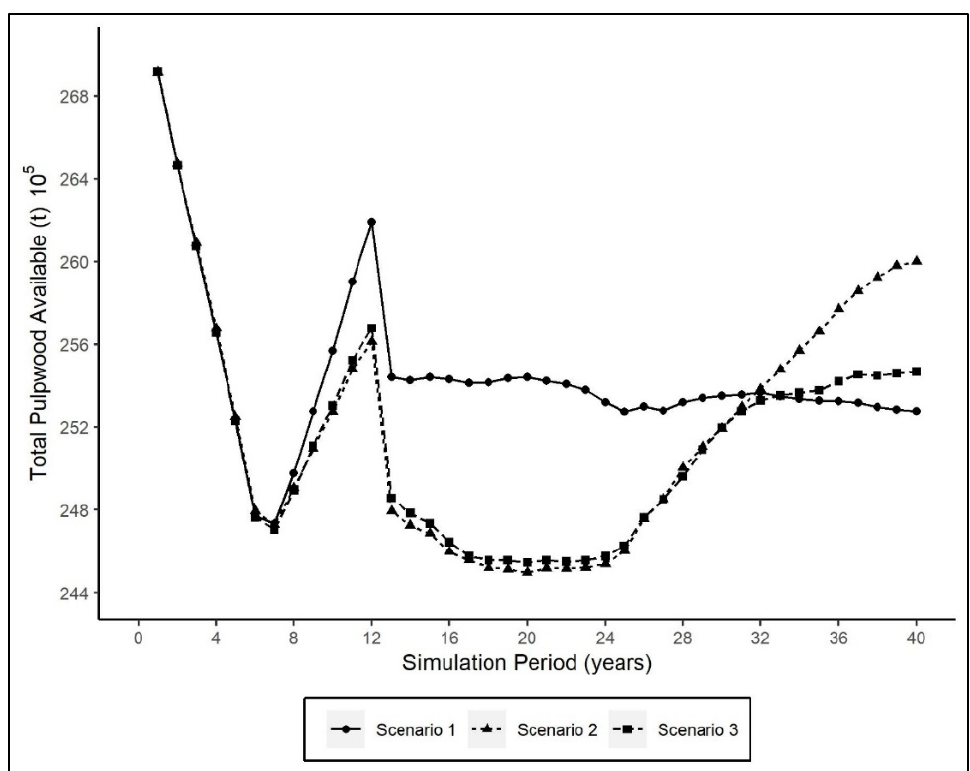
Figure 5. Distribution of total pulpwood availability at the landscape level over the simulation period. Scenarios 1, 2 and 3 are differentiated in Table 1.